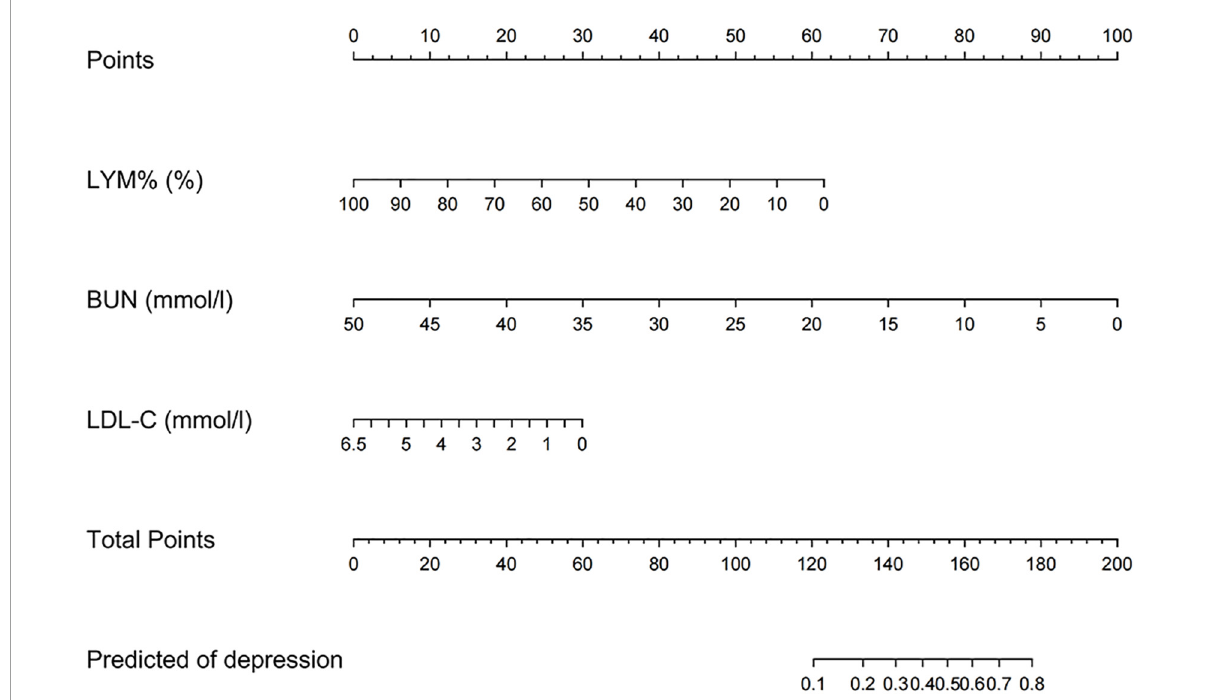
FIGURE2 Nomogram predicting depression in patients with coronary heart disease